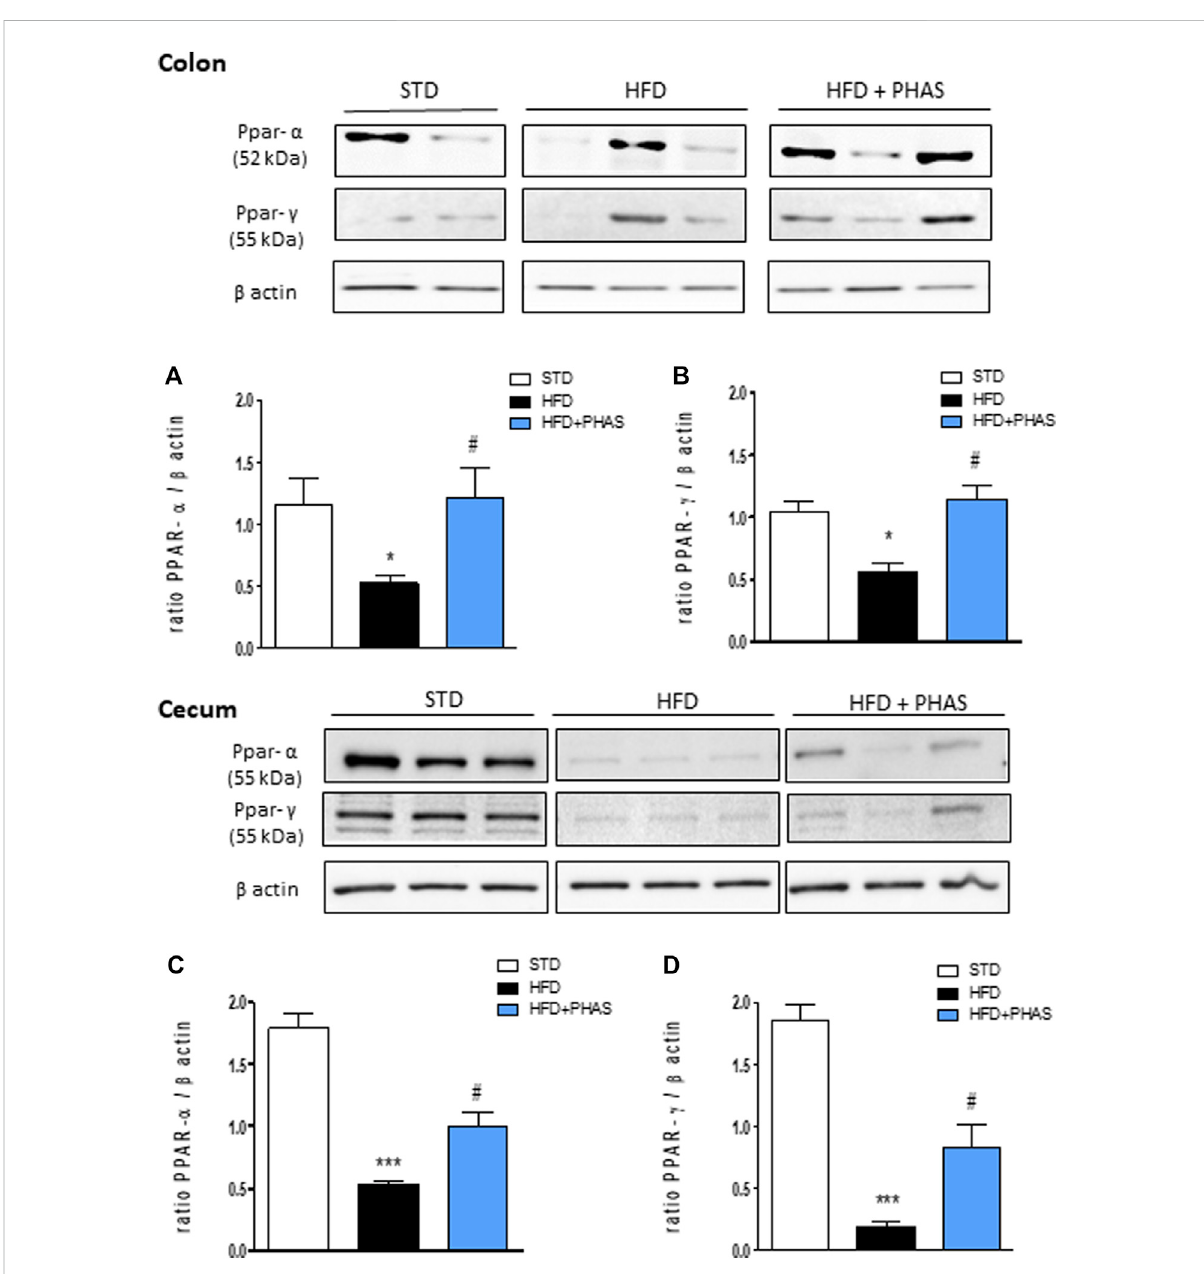
FIGURE 4 Effect of P. vulgaris extract (500 mg/kg, PHAS 500) on PPAR alpha (A,C) and gamma (B,D) and expressions in colon and cecum HFD mice, respectively, reported as the ratio of optical densities of their bands to β -actin. Immunoblot representatives were shown. Densitometric evaluations of protein levels were reported. Data are expressed as means ± SEM ( n = 6). * p < 0.05 and *** p < 0.001 vs. STD; # p < 0.05 vs.